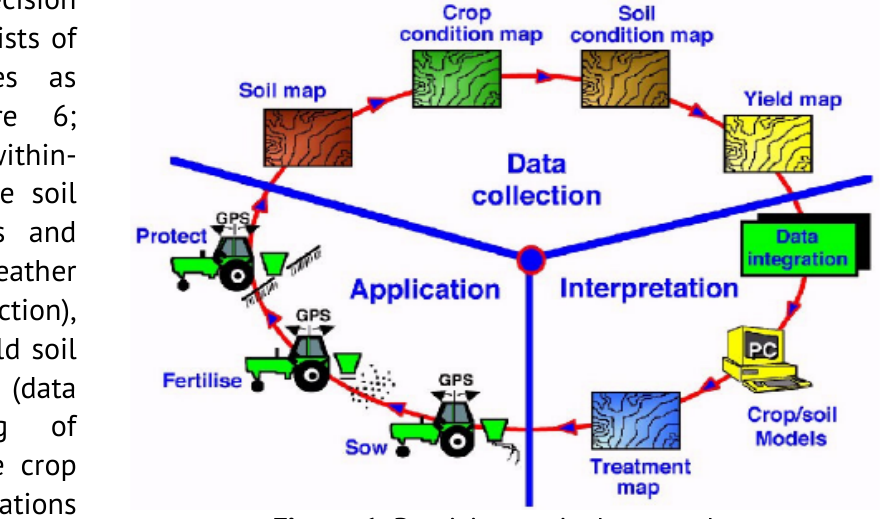
Figure 6. Precision agriculture